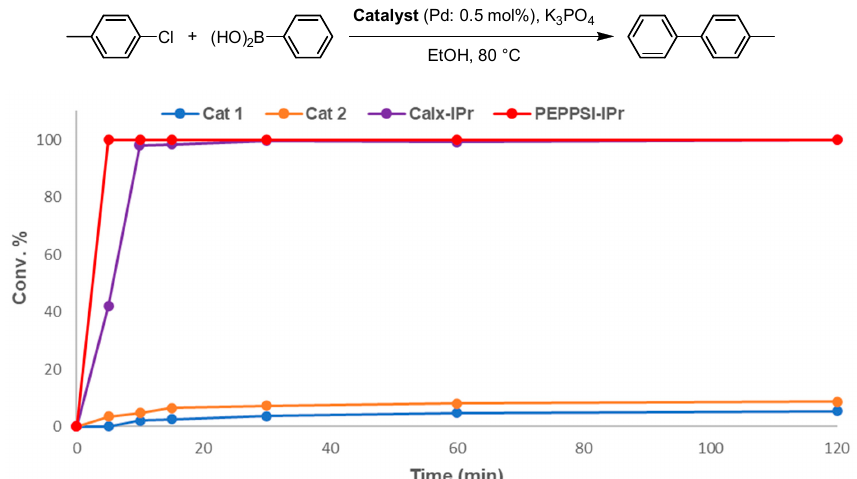
Figure 5. Conversion/time plots for various catalysts. 4-chlorotoluene (1 equiv., 1 M), phenylboronic acid (1.5 equiv.), K 3 PO 4 (2 equiv.), [Pd] = 0.5 mol%, 80 °C, reaction performed under argon